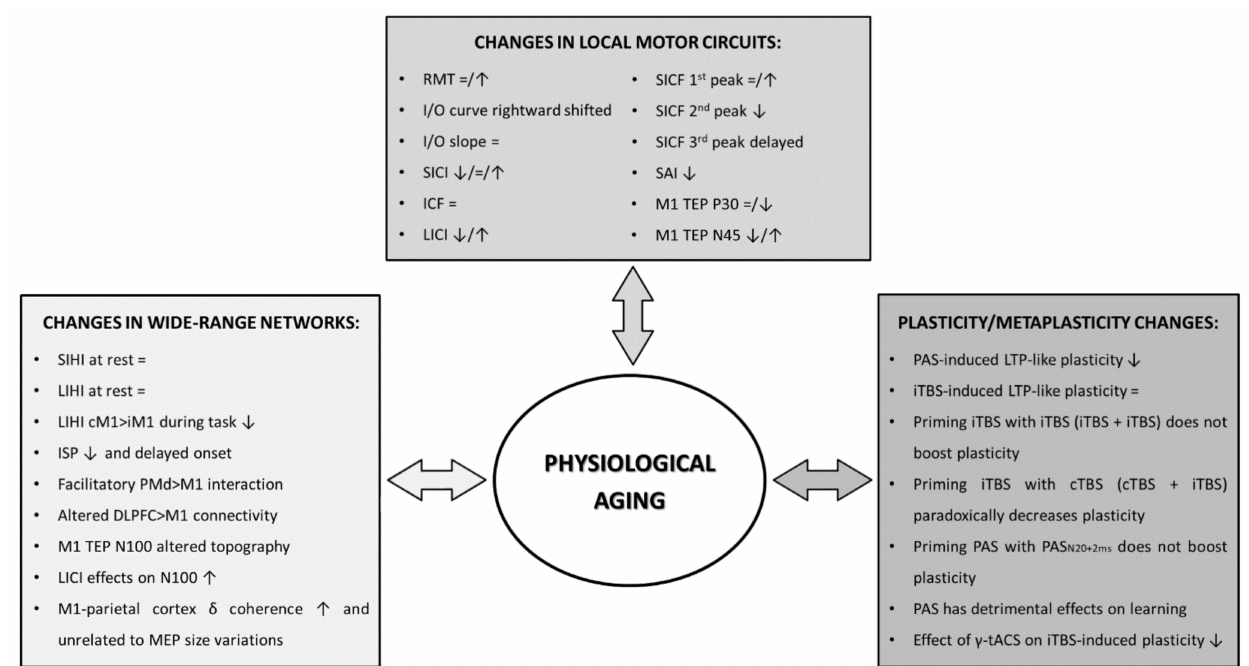
Figure 1. Age-related changes in local motor circuits, wide-range networks and plasticity processes RMT: resting motor threshold; I/O curve: input-output curve; SICI: short-interval intracortical inhibition; ICF: intracortical facilitation; LICI: long-interval intracortical inhibition; SICF: short-interval intracortical facilitation; SAI: short-latency afferent inhibition; M1: primary motor cortex; TEP: transcranial evoked potential; SIHI: short-latency interhemispheric inhibition; LIHI: long-latency interhemispheric inhibition; cM1: contralateral M1; iM1: ipsilateral M1; ISP: ipsilateral silent period; PMd: dorsal premotor cortex; DLPFC: dorsolateral prefrontal cortex; PAS: paired-associative stimulation; iTBS: intermittent theta burst stimulation; cTBS: continuous theta burst stimulation; tACS: transcranial alternating current